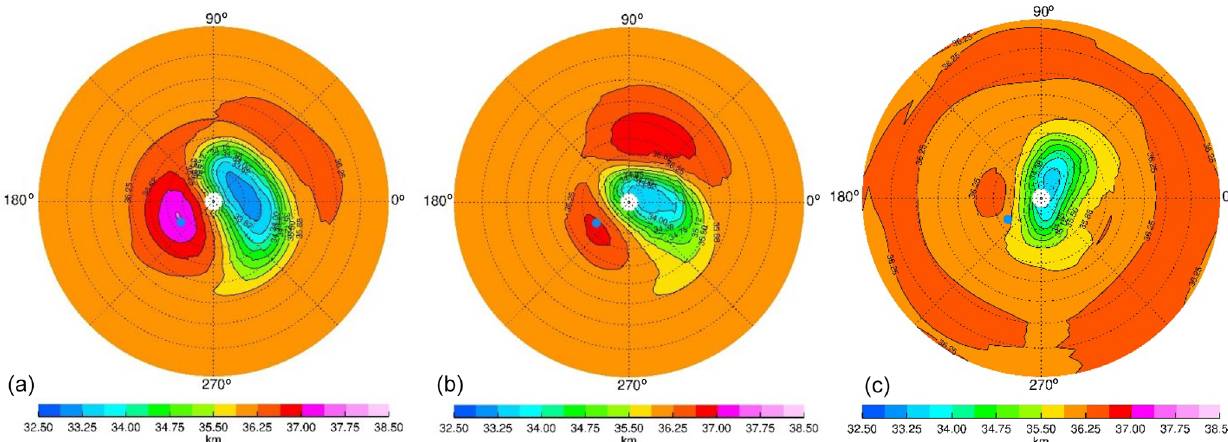
Figure 8. NH V6 GPH at 4.6hPa; CI is 0.375gpkm. Poker Flat is the blue dot. Panels are spaced 1 week apart: (a) 3 February, (b) 10 February, and (c) 17